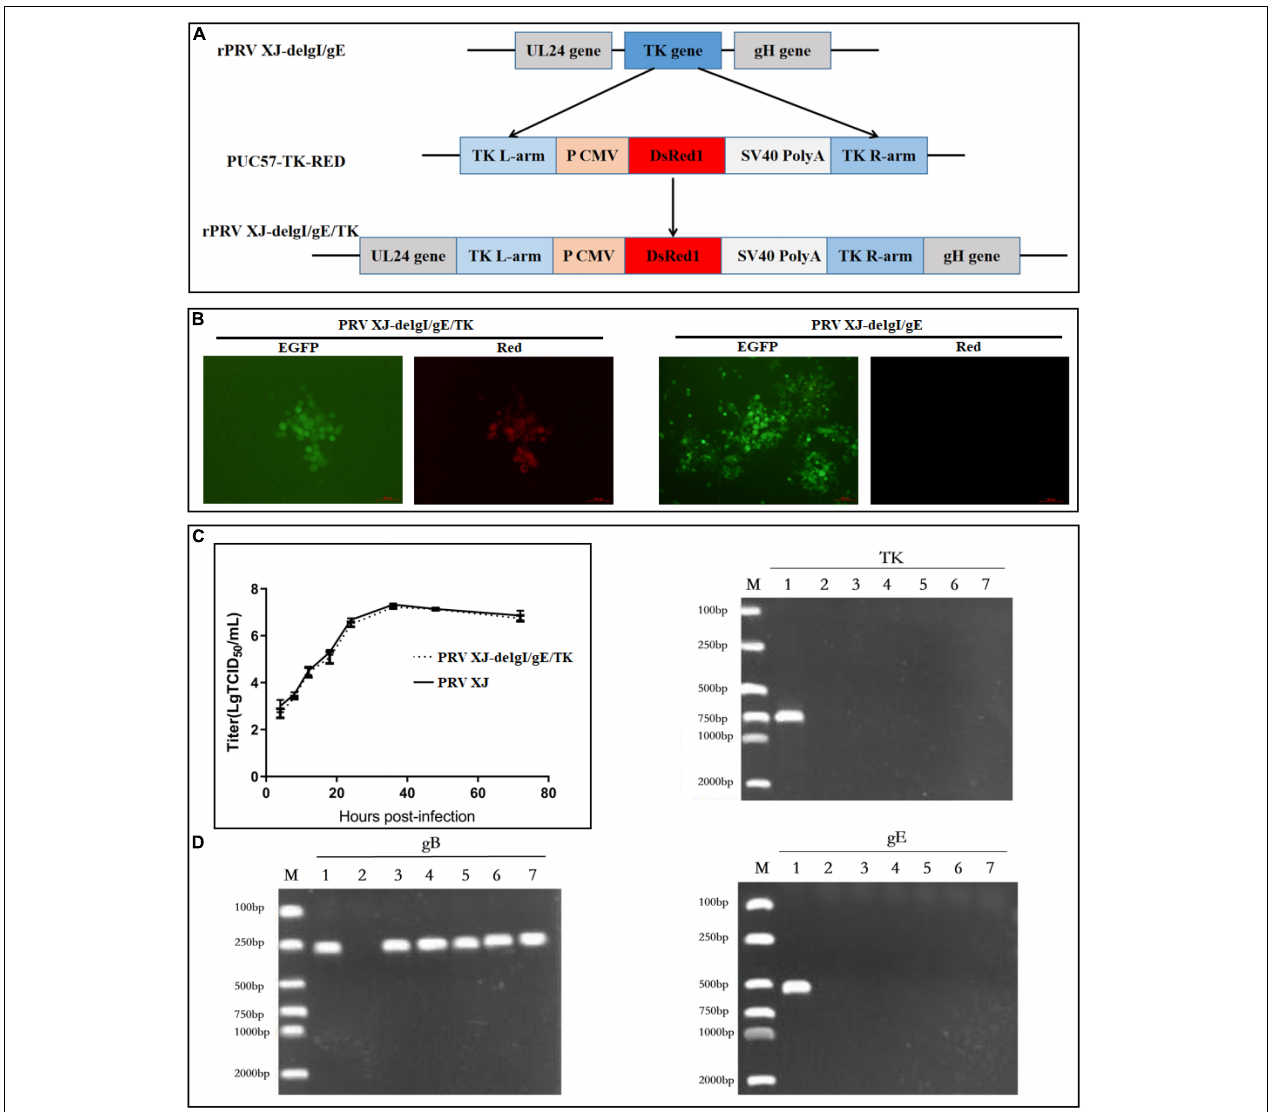
FIGURE 1 | Construction and identification of PRV XJ delgE/gI/TK. (A) Schematic diagram of the construction for PRV XJ delgE/gI/TK. (B) Identification of rescued pseudorabies virus (PRV) from the distinct cytopathic effect cells with green and red fluorescence under the fluorescence microscope. (C) One-step growth curves. The BHK-21 cells were infected with PRV XJ or PRV XJ delgE/gI/TK at multiplicity of infection = 1. At designated time points, the cells were harvested, and the viral titers were measured. (D) gE/gI/TK deletion was verified in PRV XJ delgE/gI/TK genome by PCR. M, DL 2000 Marker; 1, PRV XJ; 2, H 2 O; 3–7,